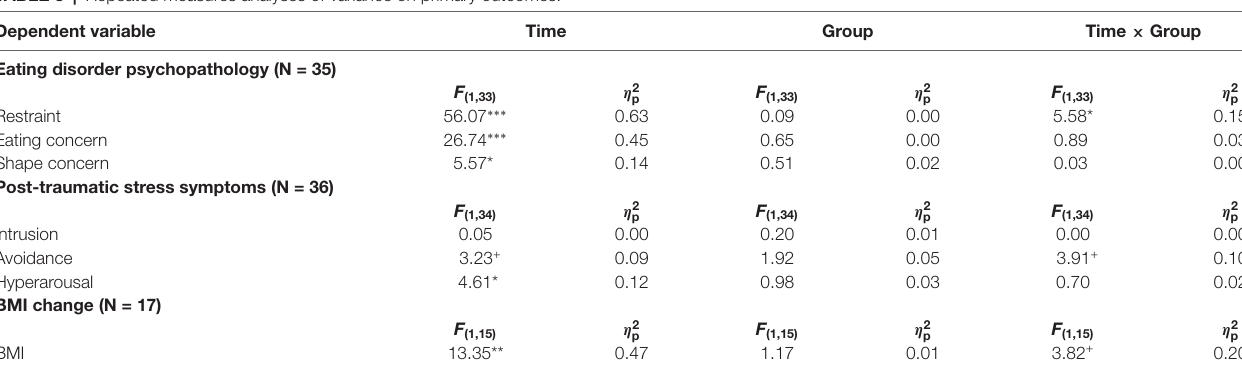
TABLE 3 | Repeated measures analyses of variance on primary outcomes. Dependent variable